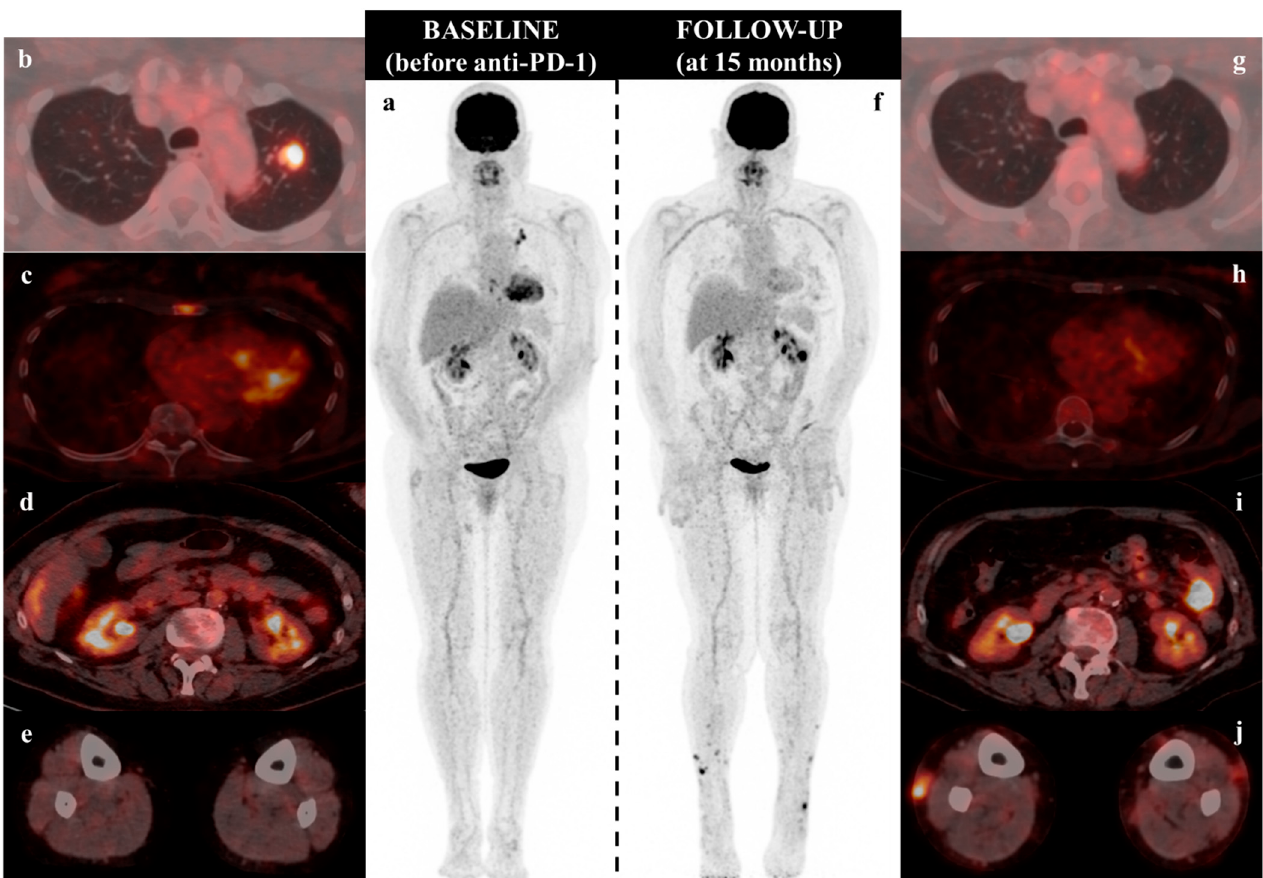
Figure 1. [18F]-FDG PET/CT scans with MIP (maximum intensity projection: ( a , f ) and fused axial images at the initiation of PD-1 inhibitor as single-agent and follow-up (15 months). The injected dose of FDG and the time of acquisition stays comparable across examinations and the maximum standardized uptake value (SUVmax) was used for measuring the uptake of FDG by pathological tissue. The patient received Nivolumab 240 mg every two weeks for the first six cycles and then 480 mg every four weeks, without any dose reduction. Assessment of response to immunotherapy was performed using CT scans every 2–3 months. While a partial morphologic response had been obtained at two months, the best overall response was achieved at seven months with a complete response. At 10 months, very small skin lesions occurred on the legs, and the radiologic presentation strongly suggested progressive disease at 14 months with the appearance of a mesenteric lymph node metastasis. [18F]-FDG PET/CT scan was thus performed for restaging, which confirmed the complete metabolic response in the upper lobe of the left lung ( b ) SUVmax 9.0 and ( g ) no pathologic uptake and in the sternal bone ( c ) SUVmax 5.5 and ( h ) no pathologic uptake. Moreover, we confirmed the presence of a mesenteric lymph node ( d ) no pathologic uptake and ( i ) SUVmax 13.1, sticking to the colonic wall, which explains why it can hardly be individualized. PET/CT exam also revealed the appearance of several FDG-avid subcutaneous nodules on her legs ( e ) no pathologic uptake and ( j ) SUVmax 10.5 on the left leg and 10.2 on the right leg. Such findings have been reported in patients with non-small cell lung cancer [1], esophageal cancer [2], and ocular melanoma [3] treated by PD-1 inhibitors. Similar images have also been published in metastatic cutaneous melanoma treated by BRAF and MEK inhibitors [4]. Recently, Tetzlaff et al. reported 3 patients with advanced cutaneous melanoma treated by ICIs who developed granulomatous/sarcoid-like lesions (2 with an antibody targeting PD-1 and 1 with an antibody targeting CTLA-4) [5]. However, only one patient presented multiple subcutaneous nodules suggesting erythema nodosum, with a very different presentation from our patient. First, this patient developed subcutaneous lesions on his bilateral dorsal hands, forearms, and elbows, but not on his legs, as we described for our patient. Second, the patient developed concurrently other granulomatous/sarcoid-like lesions, as well as new hypermetabolic hilar and mediastinal lymph nodes, while for our patient, subcutaneous nodules on legs were isolated.